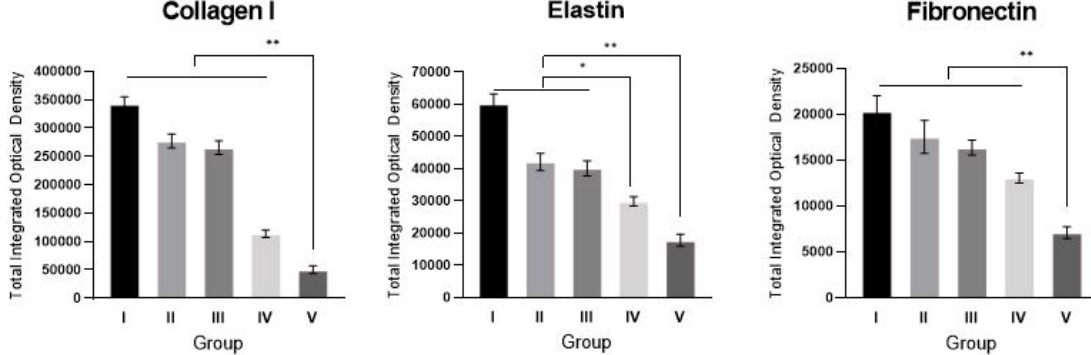
Figure 4. Representative sections of tissues from the center areas of the scar at 50th day after treatment were stained, and expression levels of type I collagen, elastin, and fibronectin were semi-quantitatively analyzed with MetaMorph ® . Values are calculated as the means of the optical density of six di ff erent digital images. The expression levels of type I collagen, elastin, and fibronectin were significantly reduced in the alginate gel encapsulating dE1-k35 / sLRP6E1E2-treated group (Group V) compared with other groups. Reduction in type I collagen was significant in Group IV compared to Groups I to III, but significantly higher (220%) than that of Group V (* p < 0.05, ** p < 0.01).